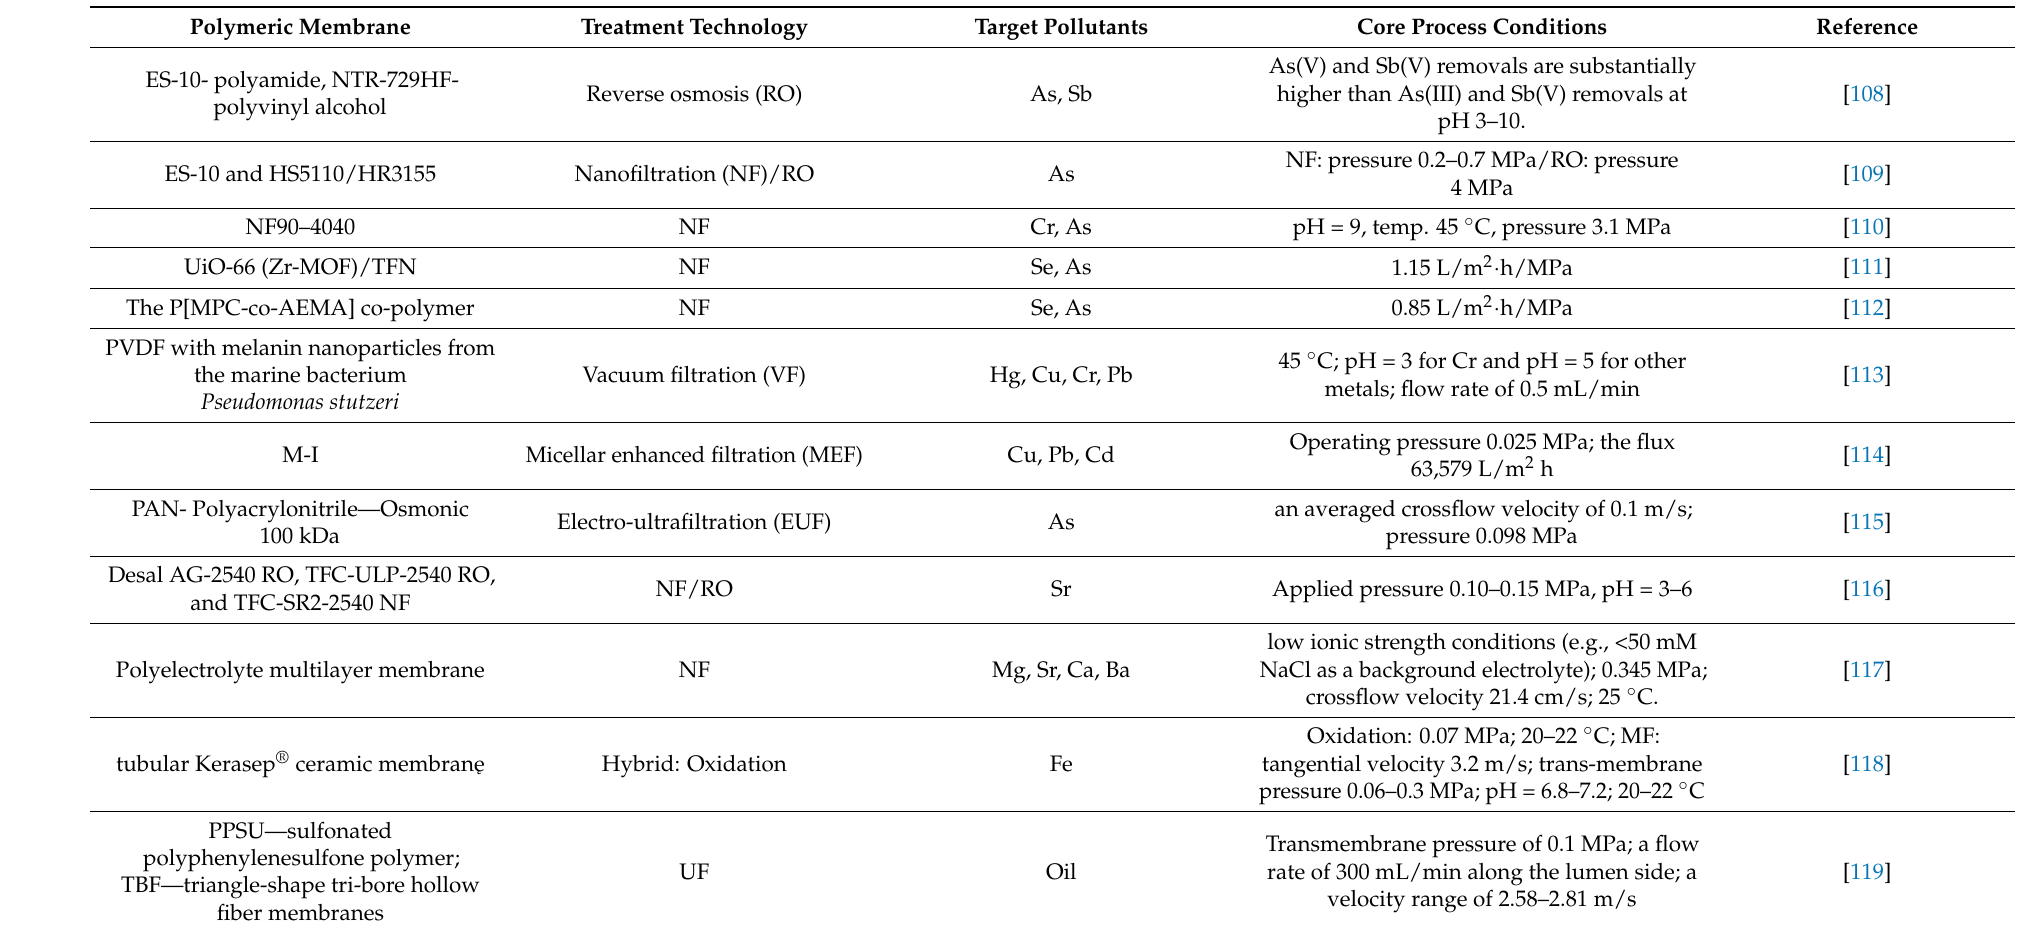
Table 3. Selected polymeric membrane nanocomposites for water treatment